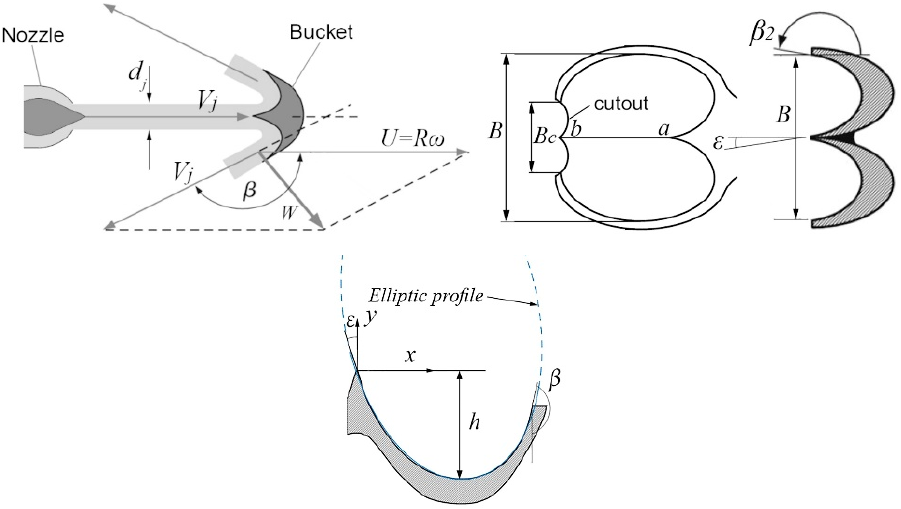
Figure 14. Bucket design for a Pelton turbine blade [29].